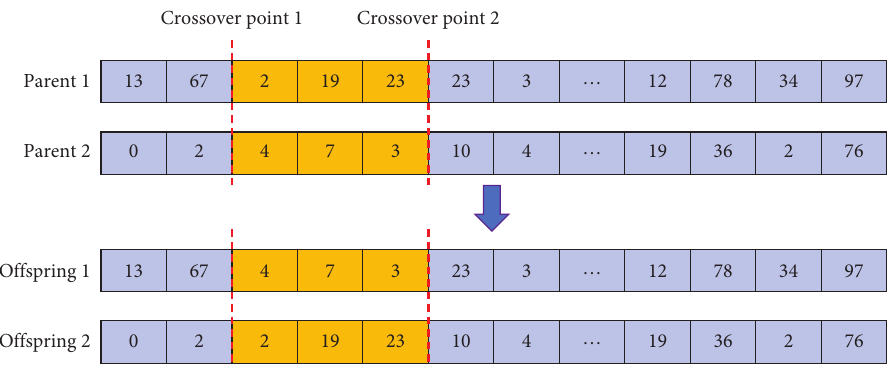
Figure 2: Schematic diagram of the chromosome crossover